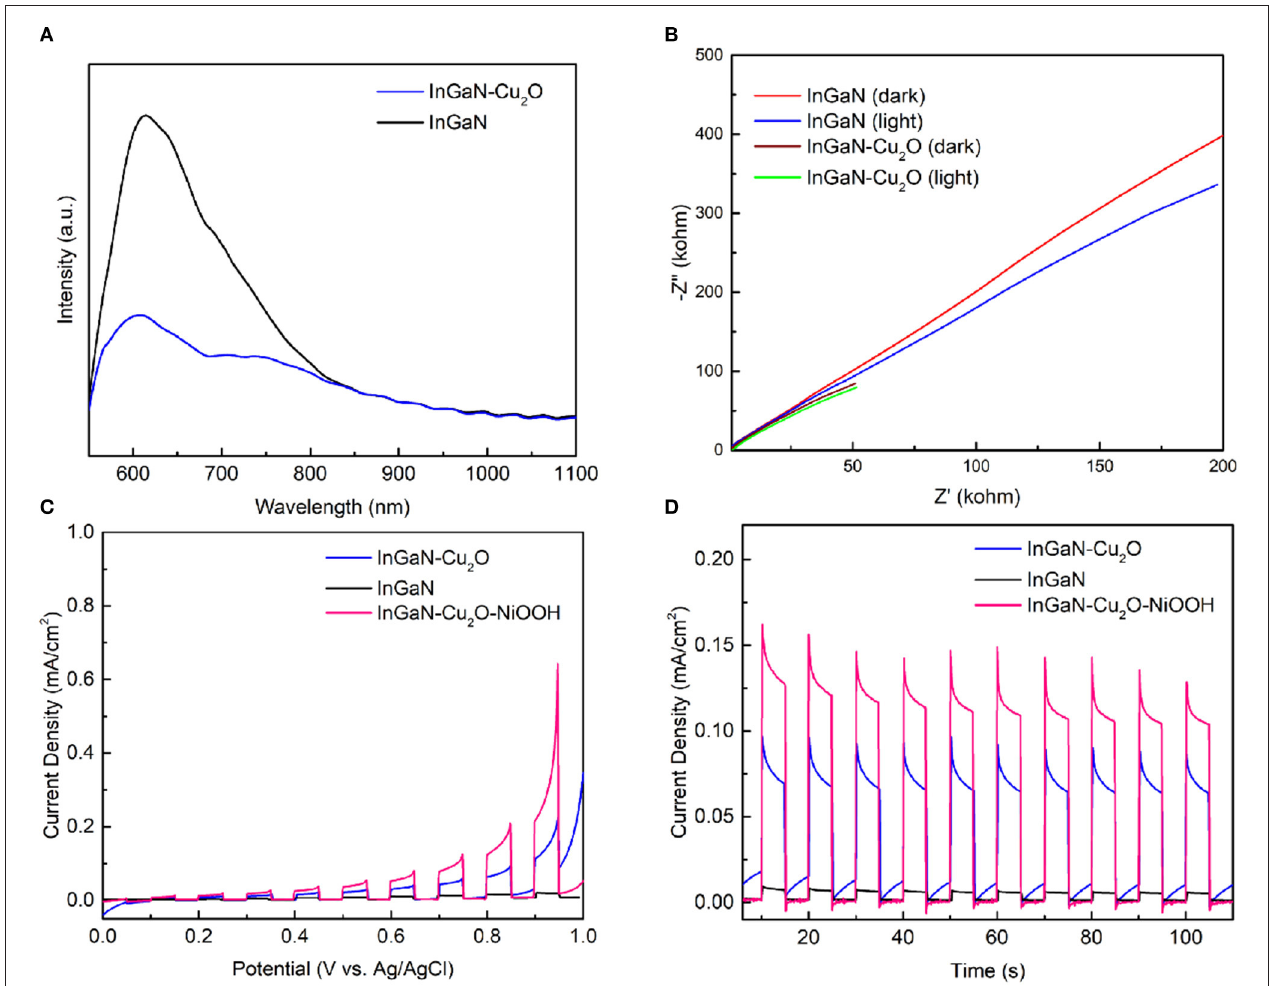
FIGURE 5 | (A) Photoluminescence (PL) spectra taken at room temperature of the InGaN/Cu 2 O core-shell NWs and the bare InGaN NWs. (B) Electrochemical impedance spectroscopy (EIS) taken at + 0.6V vs. Ag/AgCl (1.2V vs. RHE) in the dark and under illumination of the InGaN/Cu 2 O core-shell NWs and the bare InGaN NWs. (C) LSV- and (D) I–t measurements at + 0.8V vs. Ag/AgCl (1.4V vs. RHE) of the InGaN/Cu 2 O/NiOOH complete NW photoanode and the InGaN/Cu 2 O core-shell NWs under chopped illumination.